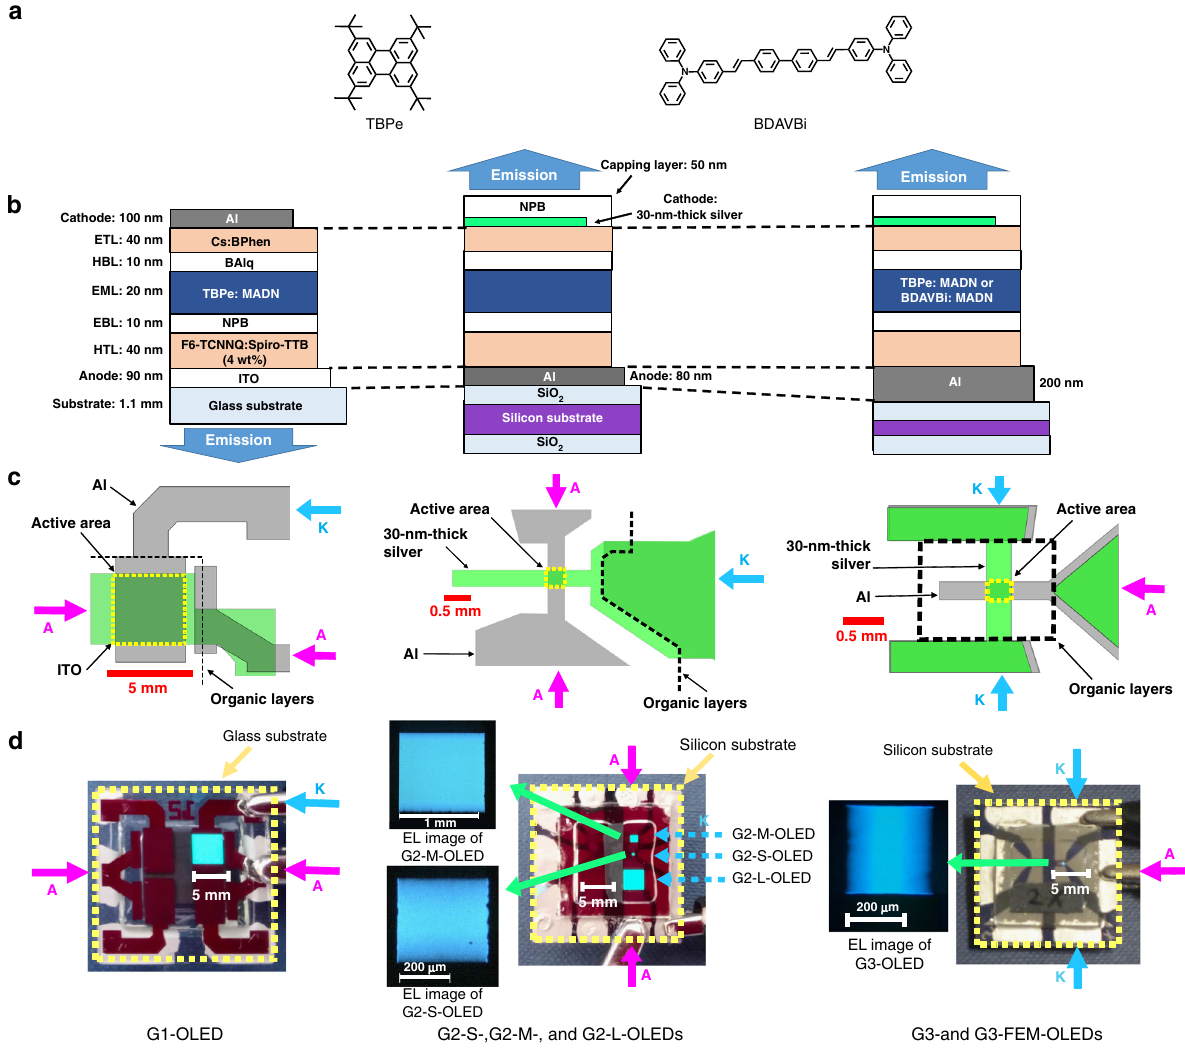
Fig. 1 Summary of the three generations of OLEDs investigated. a Chemical structure of the emitter molecules used. b Cross section of OLEDs. ETL electron transport layer, HTL hole transport layer, EML emission layer, HBL hole blocking layer, EBL electron blocking layer. c Schematic illustrations of the top view of the OLEDs. Purple arrows indicate the contacts for anode (A) and blue arrows indicate the contacts for cathode (K). d Photographs of the OLEDs and corresponding images under a microscope of devices emitting blue